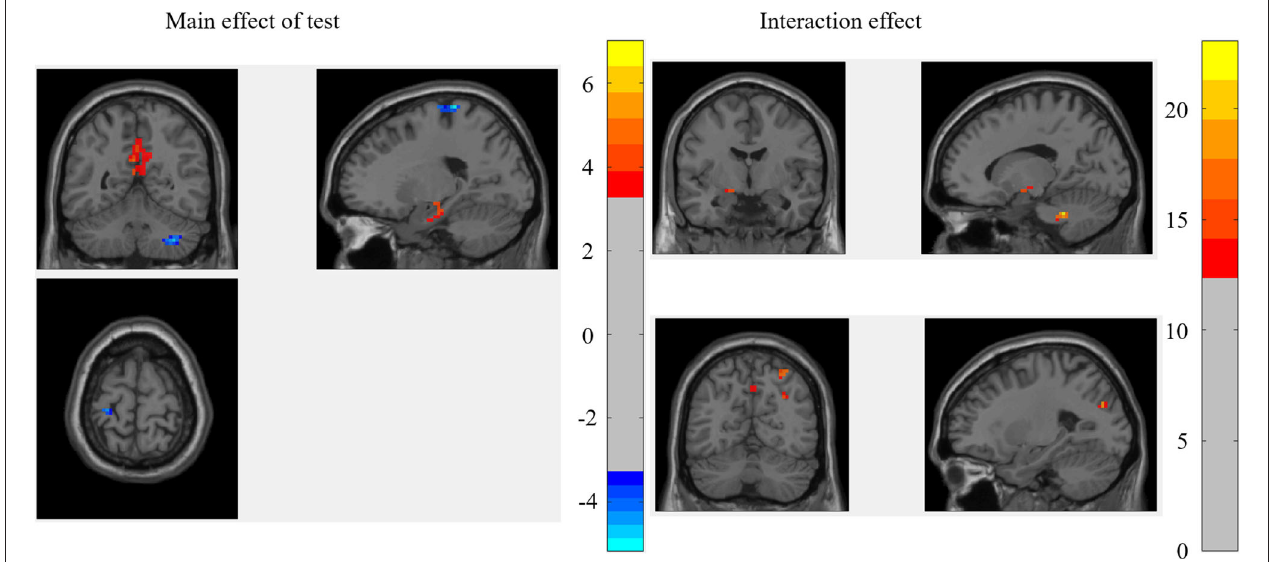
FIGURE 1 | The brain regions that were significant in the mixed-effect analysis of the binary graph.